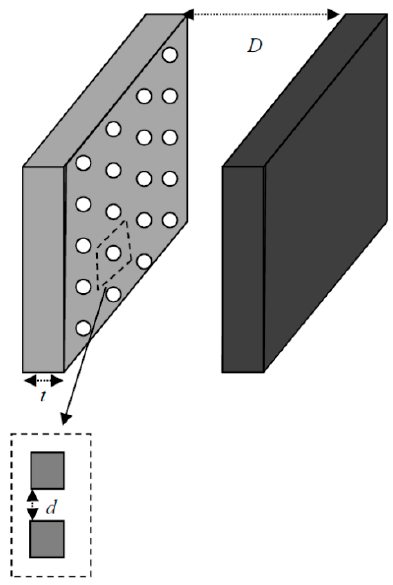
Figure 1. Sketch of a single-layer microperforated panel (SL-MPP).